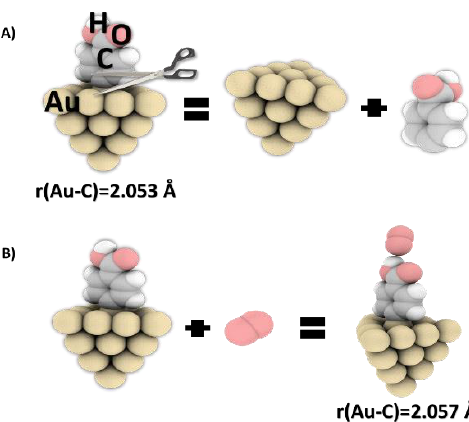
8 of 11 Figure 6. Optimized geometries of gold surfaces grafted with carboxyphenyl groups in absence and presence of oxygen molecule (level of theory: GGA/DND/TS). ( a ) Au-CP; ( b ) Au-CP/O 2 ; ( c ) Au-2CP; ( d ) Au-2CP/O 2 .